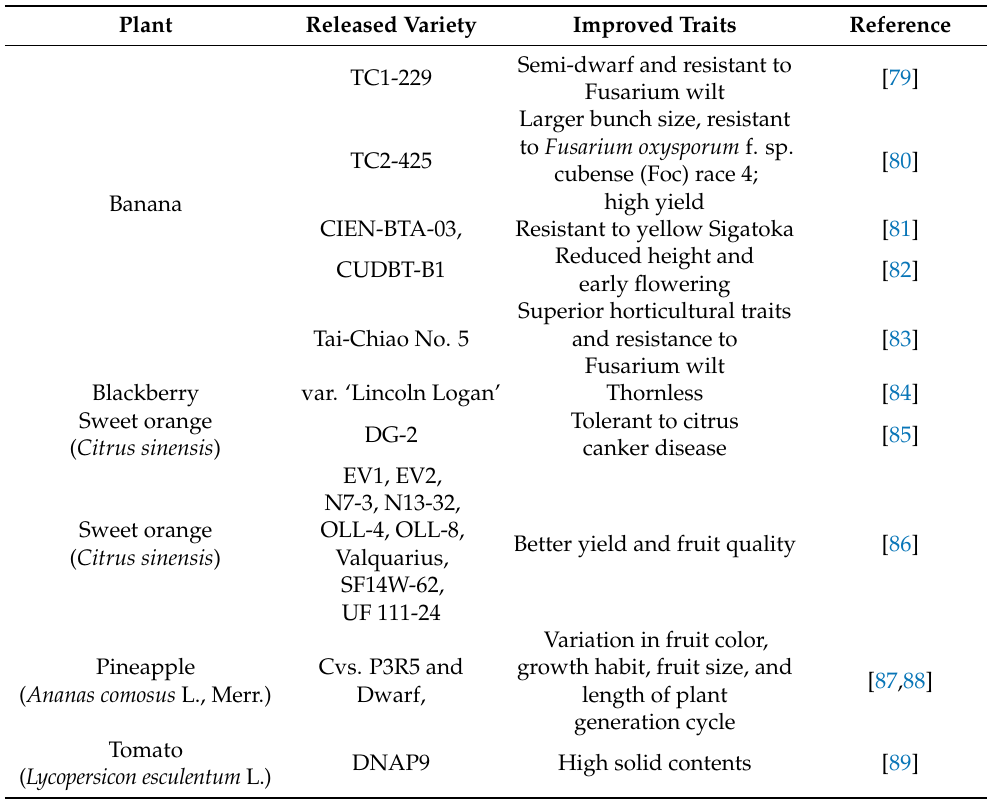
Table 1. Some examples of soma clonal (genetic) variability and development of new varieties in different plants